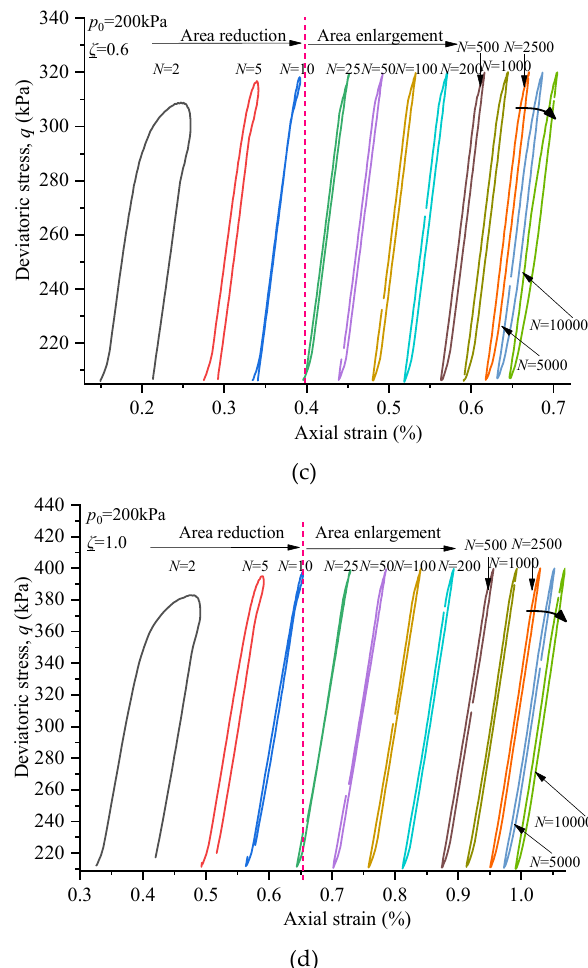
Figure 9. Hysteresis loop of coral sand under cyclic loading (take the samples of p 0 = 200k Pa as an example): ( a ) p 0 = 200 kPa, ζ = 0.2; ( b ) p 0 = 200 kPa, ζ = 0.4; ( c ) p 0 = 200 kPa, ζ = 0.6; ( d ) p 0 = 200 kPa, ζ =